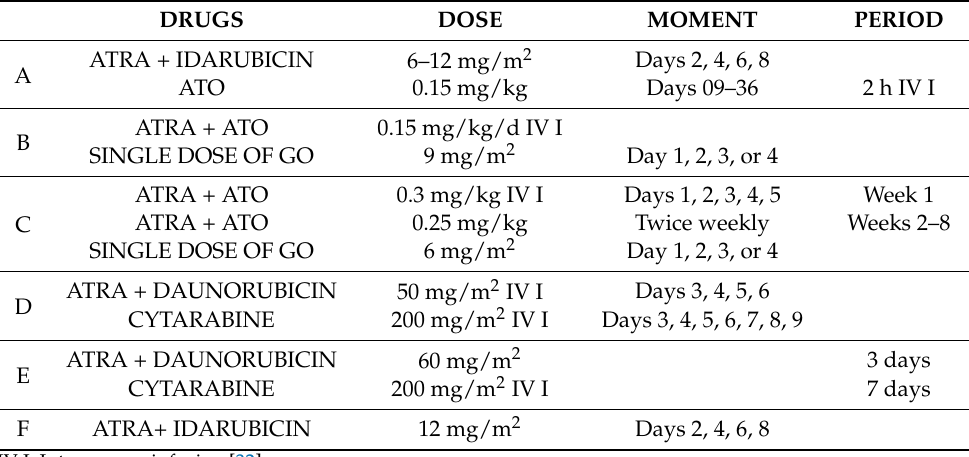
Table 2. Recommended therapy for high-risk APL